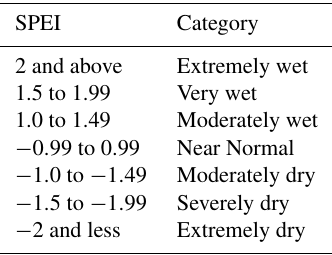
Table 1. Categories of dry and wet conditions indicated by SPEI